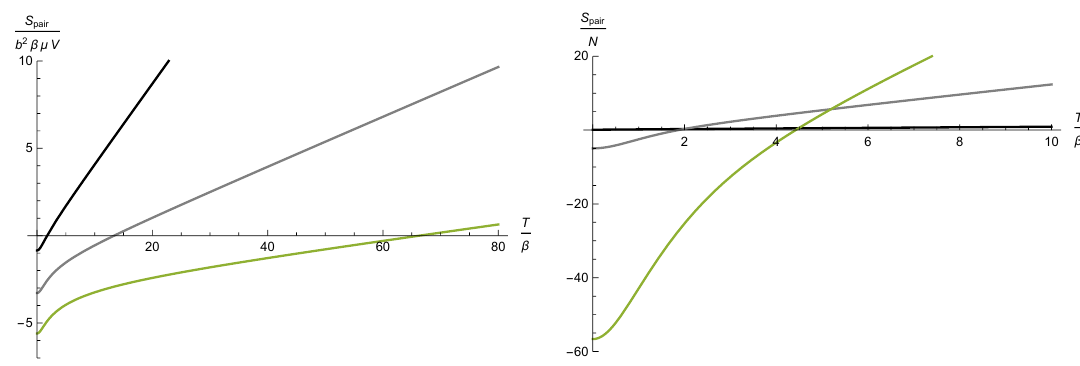
Figure 6 . (Left) The action of the 3-brane pair in the torus wormhole, analytically continued to real time. The upper black curve corresponds to a mass-to-charge ratio x = 1 . 1 , the middle gray curve to x = 1 . 01 , and the lower curve to x = 1 . 001 . The time T c at which the action passes through zero denotes the time after which the brane nucleation instability is lifted. (Right) The action of the non-BPS string pair in an AdS 3 × S 3 × T 4 wormhole with torus boundary, analytically continued to real time. The black curve corresponds to b = 1 . 2 , for which the action is always positive; the gray curve to b = 2 , and the dark green curve to b = 3 . The wormhole is then stable against brane nucleation after sufficient real time